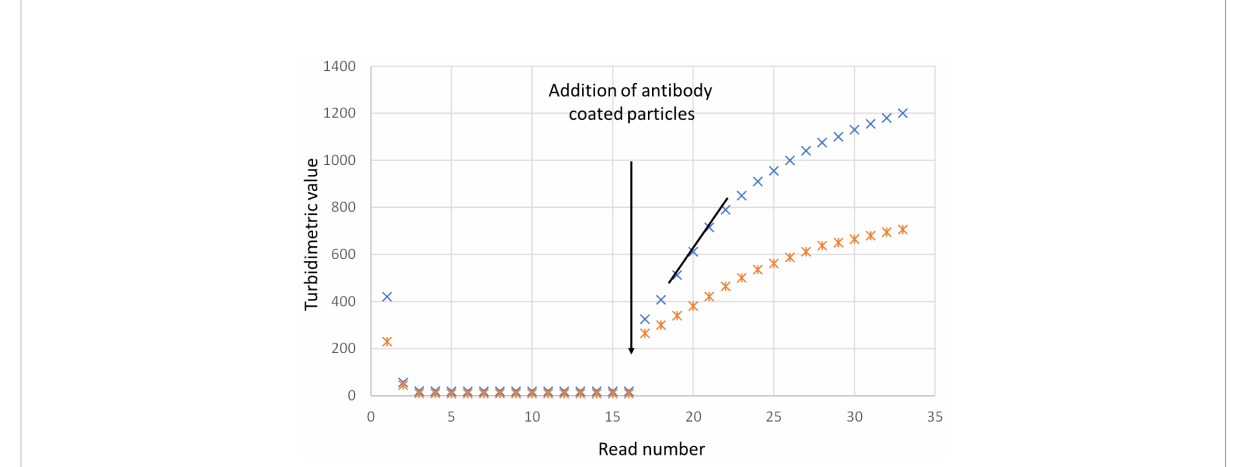
FIGURE 3 Presentation of the turbidimetric readings when analyzing cystatin C on an Architect c8000. The samples were analyzed as singletons. The instrument measures the turbidimetric readings every eighteenth second. The readings are shown for two samples, one sample with a cystatin C concentration of 7 mg/L (upper curve) and one sample with a cystatin C concentration of 3.5 mg/L. The antibody coated particles are added after position 16. The reaction between the particles and the sample can be measured as endpoint or rate readings. Rate is the steepest slope of the readings after position 18 and is represented in the fi gure as a black line.